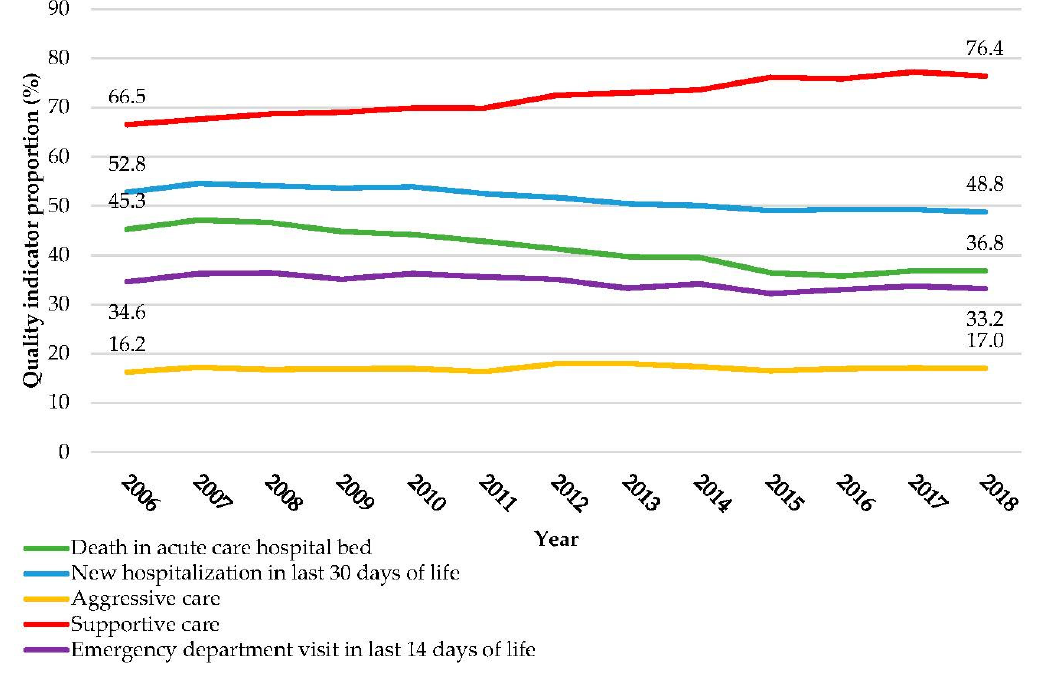
Figure 1. Quality Indicator Proportions by Year of Death.